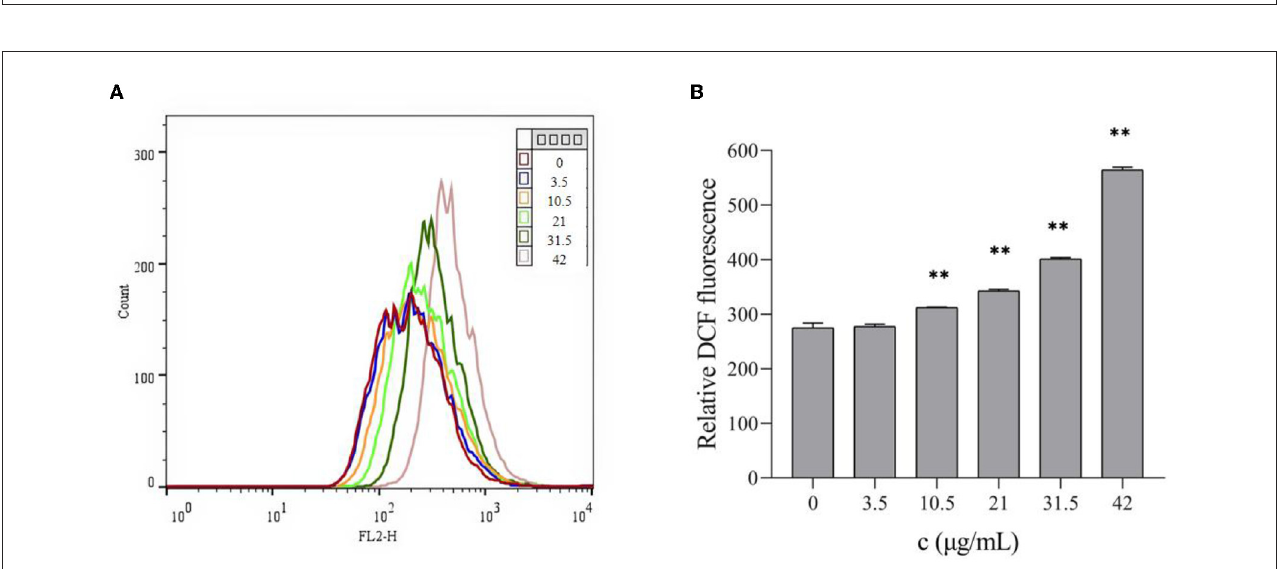
FIGURE3 Effects of different concentrations of TG on the ROS levels of HepG2 cells. (A) The level of ROS was detected by flow cytometry. (B) Different concentrations of TG induced relative ROS production in HepG2 cells. ** P < 0.01.